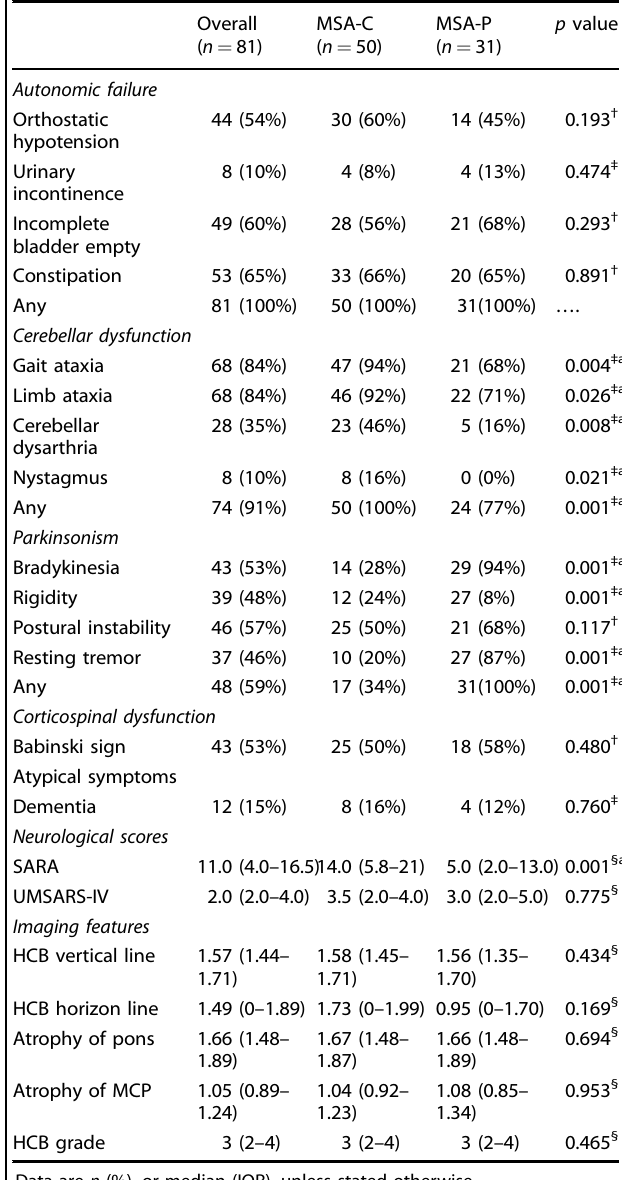
Data are n (%), or median (IQR), unless stated otherwise. † Based on χ 2 test, signi fi cance level of 0.05 (two-tailed). ‡ Based on Fisher ’ s exact test (if any cell has fewer than ten observations) with level of signi fi cance set to 0·05 (two-tailed). § Based on Mann – Whitney test with signi fi cance level of 0.05. a Signi fi cant difference between MSA-C and MSA-P patients, P <0.05. UMSARS Uni fi ed Multiple System Atrophy Rating Scale, MSA-C multiple system atrophy (cerebellar subtype), MSA-P multiple system atrophy (parkinsonism subtype). MCP middle cerebellar peduncles. SARA Scale for Assessment and Rating of